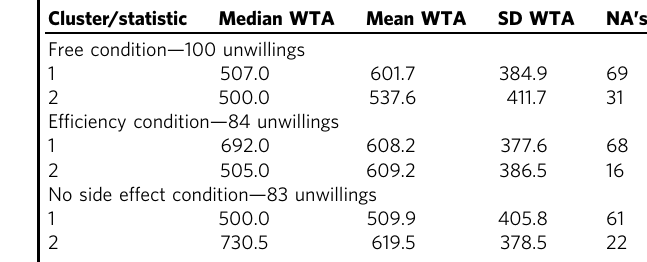
Fig. 7 Sum of squared errors (elbow analysis).